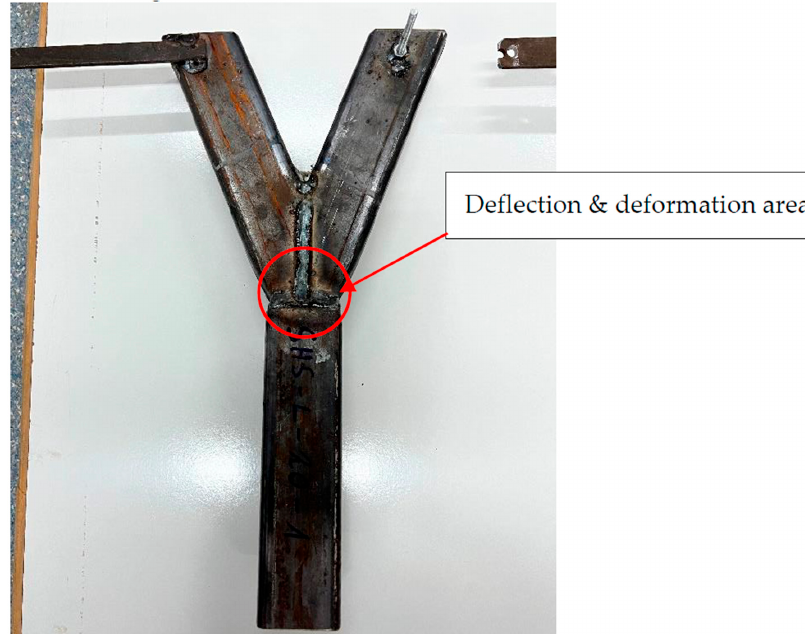
Figure 3. Deformed specimen.